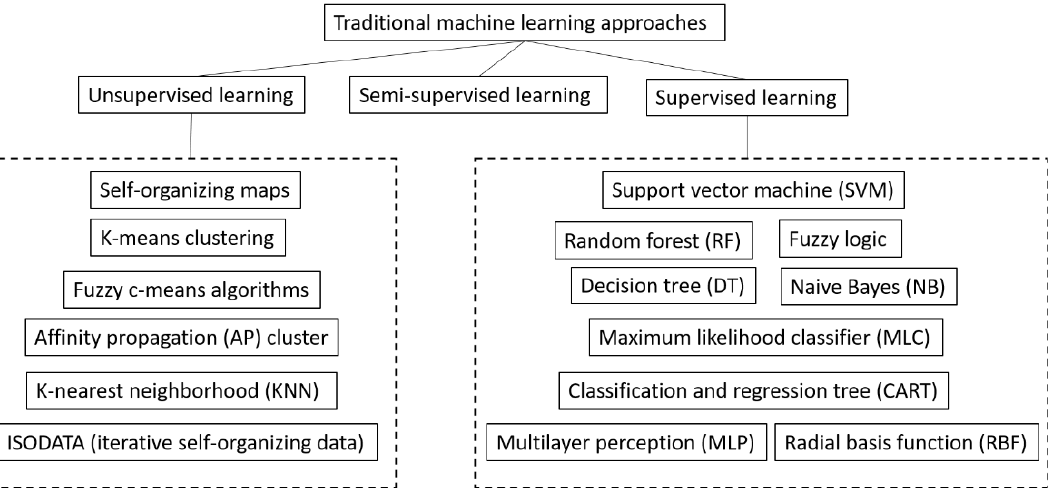
Figure 5. Types of traditional machine learning approaches for LULC mapping.